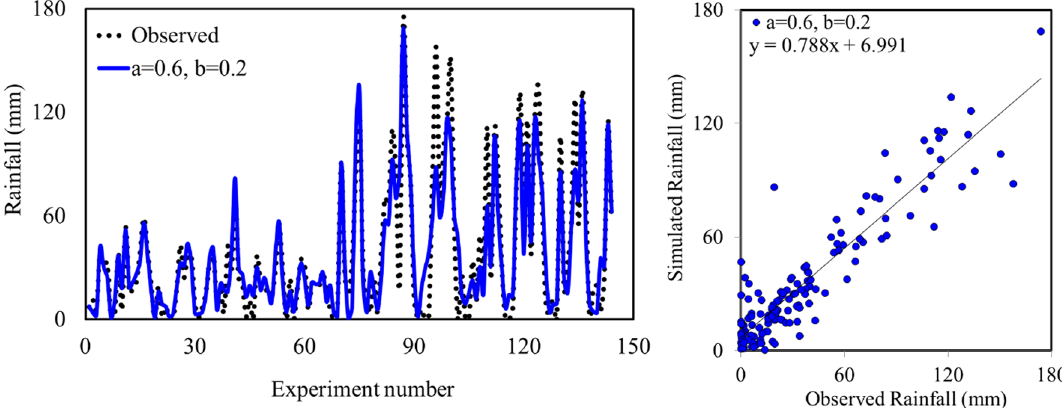
Fig. 4 Comparison of simulated precipitation values with observed